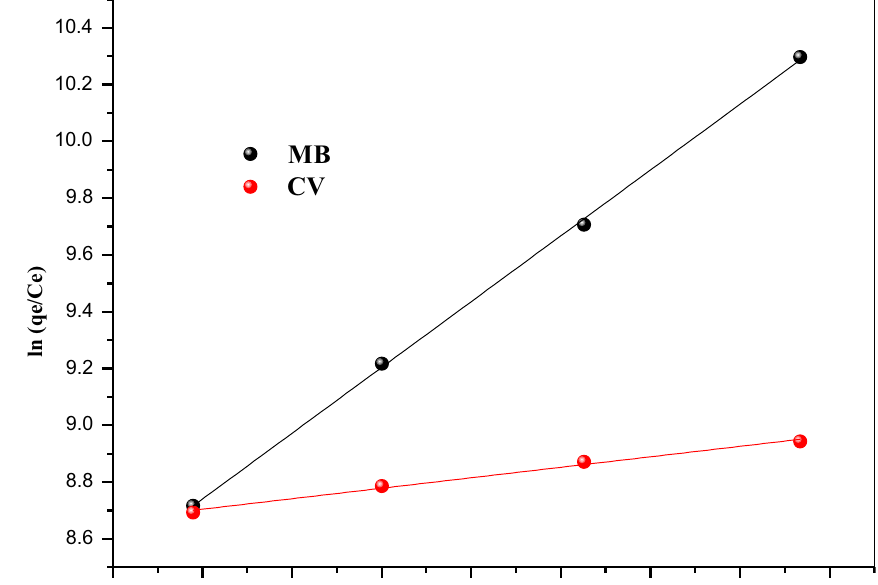
Fig. 8 ln ( q C f (1/ T ) e / e ) = plot for dyes adsorption onto ABent/A ( C 0 = 100 mg/L, m ABent/A = 10 mg, V ABent/A = 10 mL, Agit = 200 rpm, pH MB = 6.4, pH CV = 5.9)